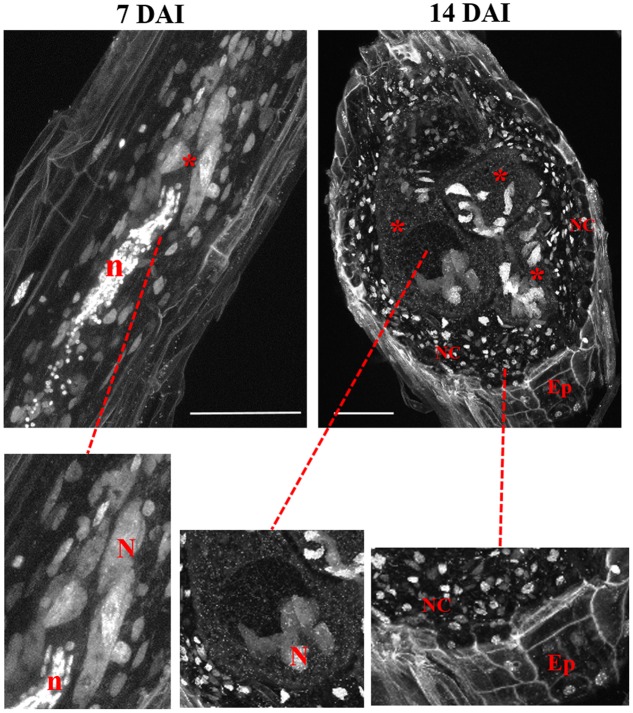
Maximum brightness projections of confocal images recorded of M. incognita-induced galls in Arabidopsis roots at 7 and 14 DAI. Both micrographs are thick sections allowing the visualization of DAPI-stained nuclei and DNA containing organelles like mitochondria and plastids in GC, neighboring cells, and epidermis. Details show nuclei in GC, neighboring cells, and epidermis. ∗, GC; NC, neighboring cells; N, nucleus; Ep, epidermis, n, nematode. Bars = 50 μm.